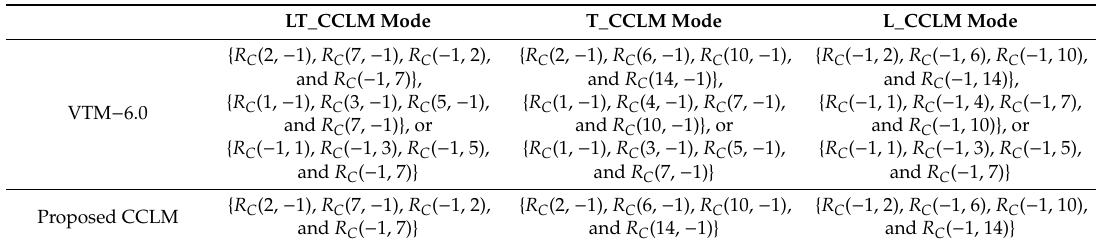
Table 3. Comparison of the positions of subsampled neighboring samples between VTM-6.0 and the proposed CCLM in the case of a given 8 × 8 chroma